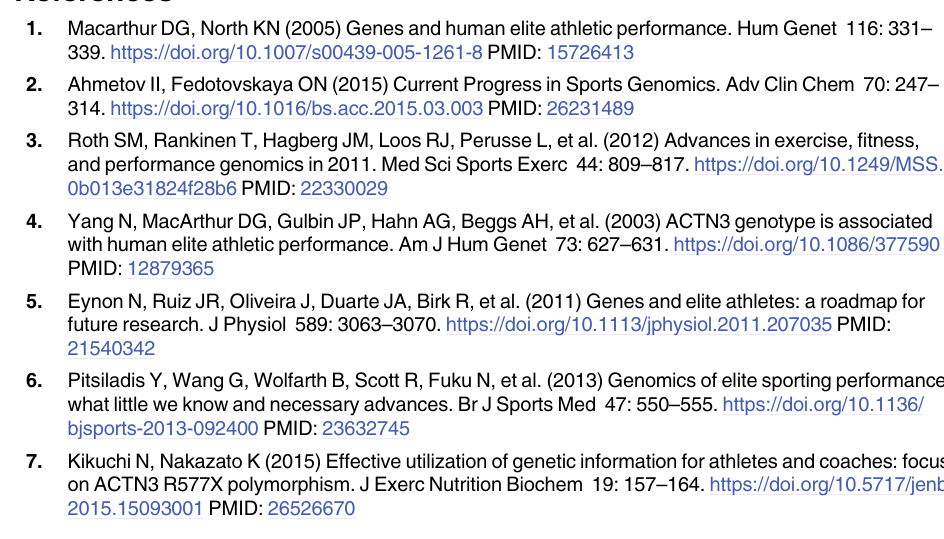
S3 Table. Quantitative data of ACTN3 R577X polymorphism studies. S4 Table. PRISMA checklist. S5 Table. Meta-analysis of genetic association checklist. S6 Table. Comparisons with other